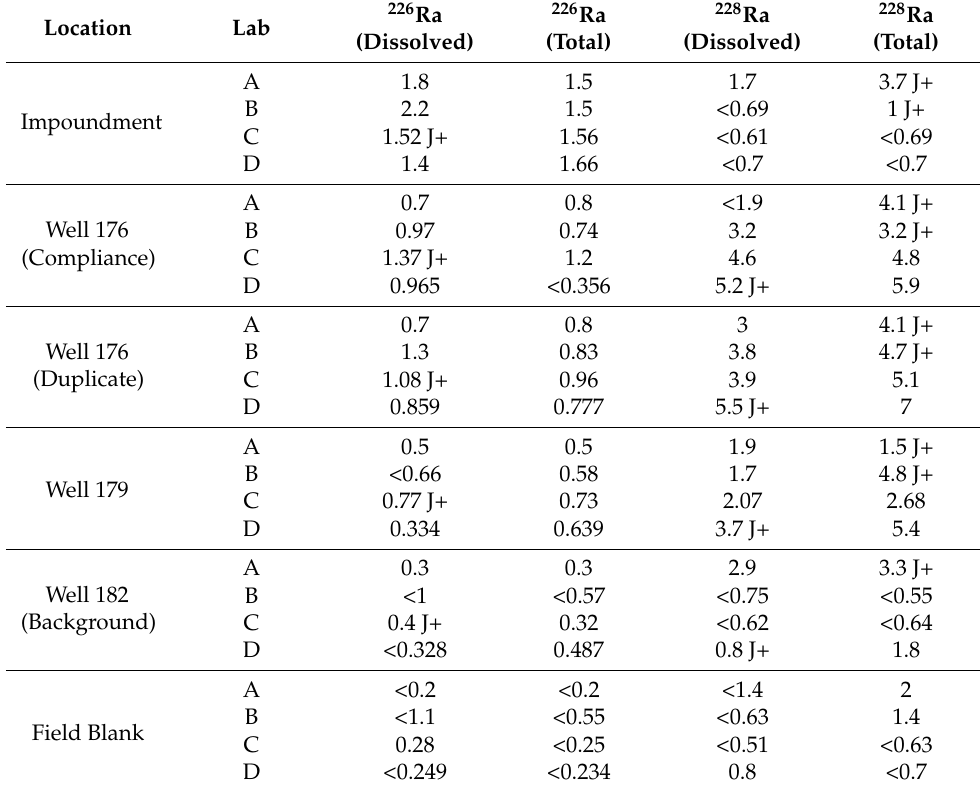
Table 3. Comparison of ILC results (pCi/L) for 226 Ra and 228 Ra 1